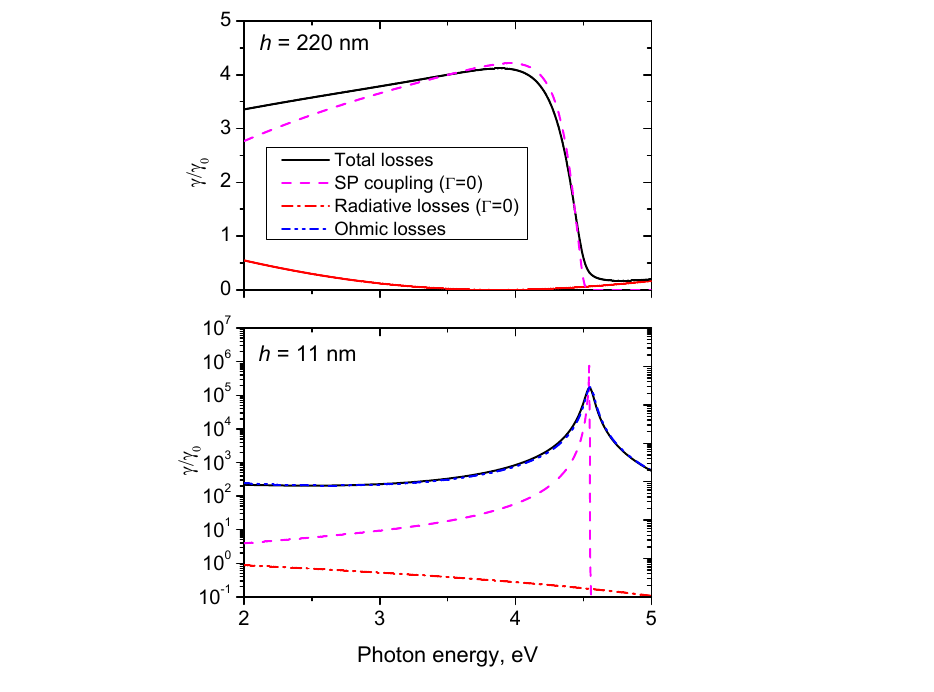
Figure 7. Spectral dependence of different contributions to the emission decay rate for a vertically oriented emitter located in a dielectric with ε 1 = 2 at two different distances (indicated on the plots) above a flat interface with gold. Note that the contribution of the Ohmic losses (the main cause of the emission quenching near metal surfaces) is negligible in the upper plot, while it is completely dominating in the lower panel. For the calculation of the radiative losses and coupling to surface plasmons, the damping parameter, Γ of the Drude model was set equal to